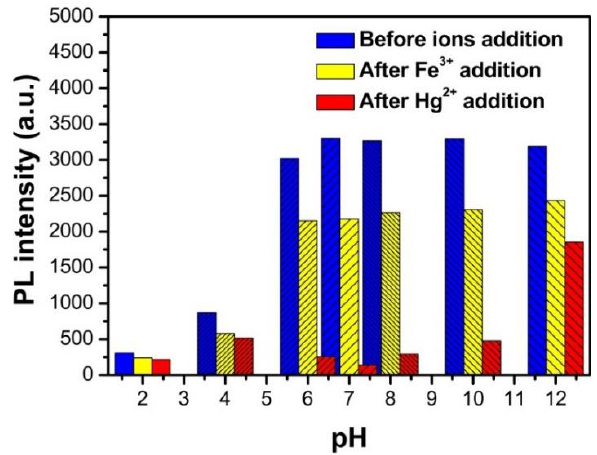
Figure 10. The dependence of fluorescence intensity on different pH of N, S-GQDs before and after the addition of 1 μM Hg 2+ or 1 μM Fe 3+ , respectively.